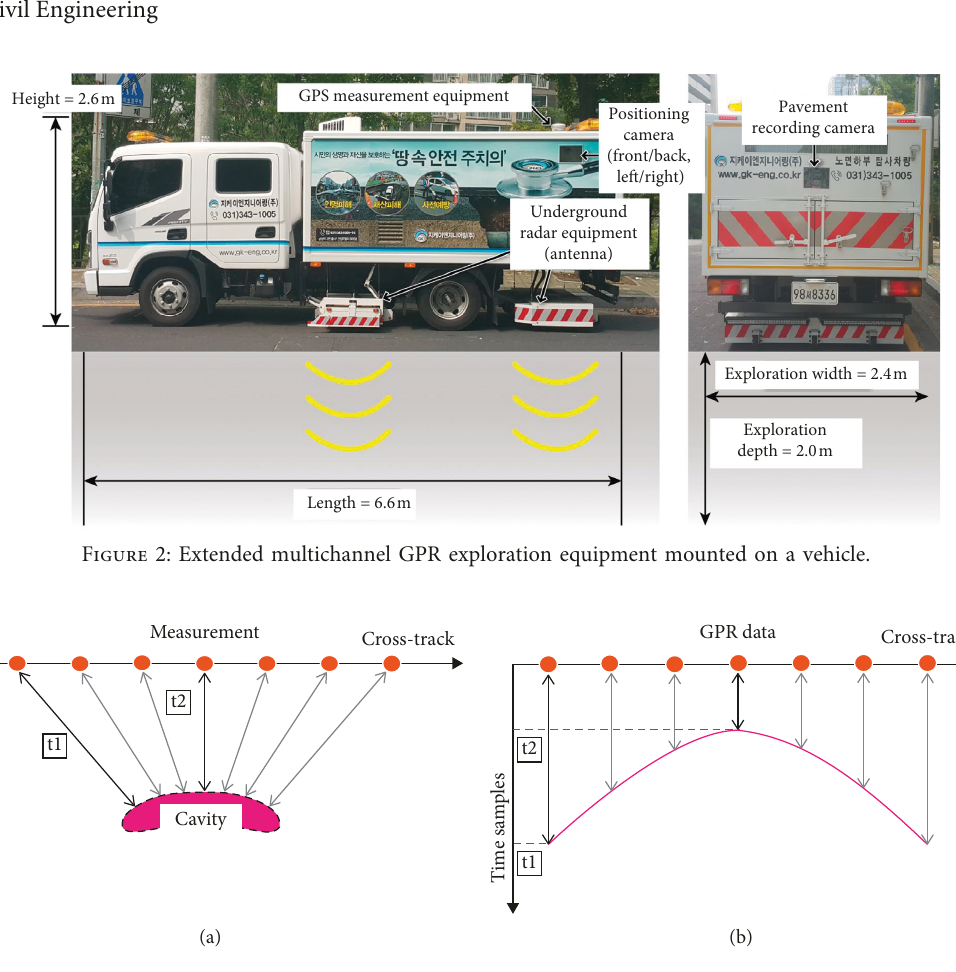
Figure 3: Parabolic signature in the GPR Data. (a) GPR detection. (b) Parabola projection of GPR data.